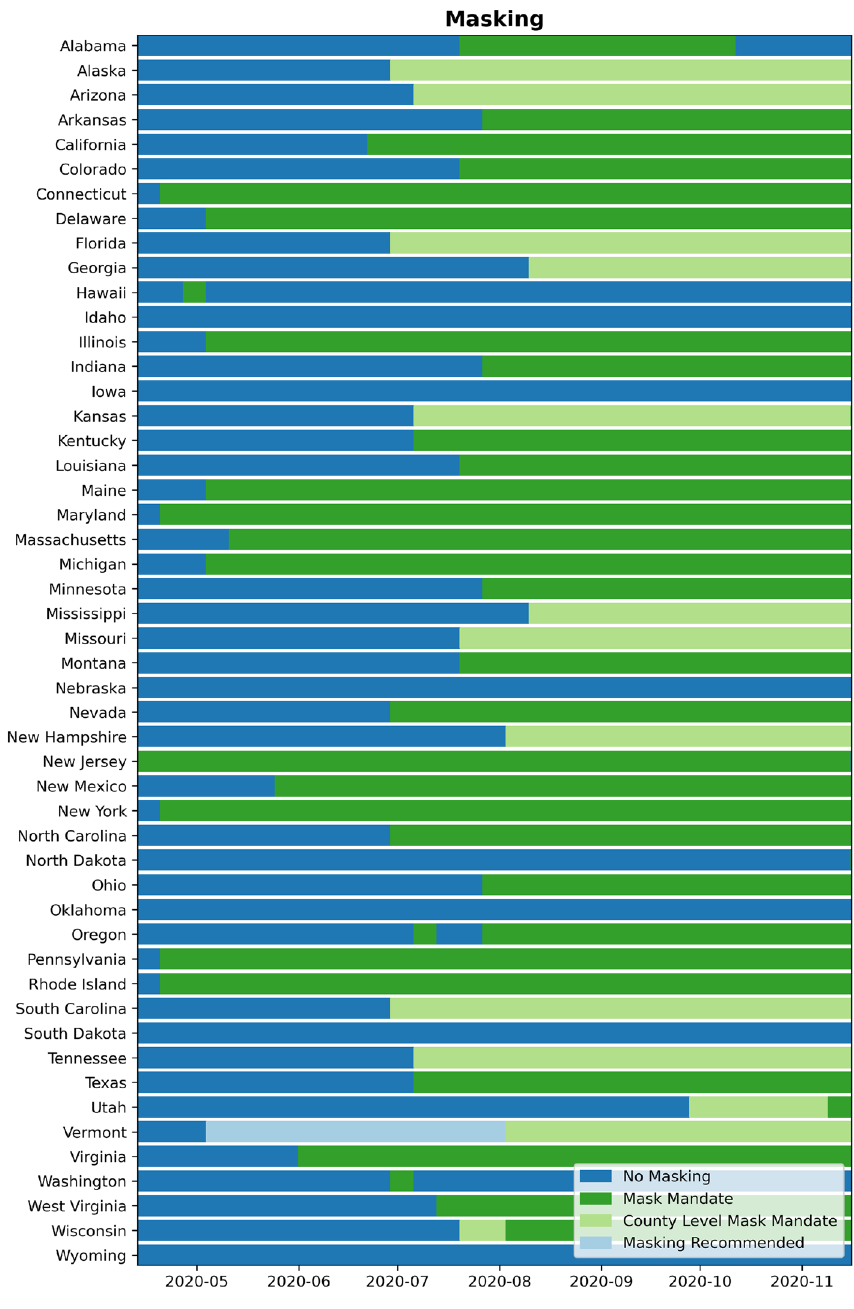
Figure 1. Timeline of various mask mandates issued across all the states in the United